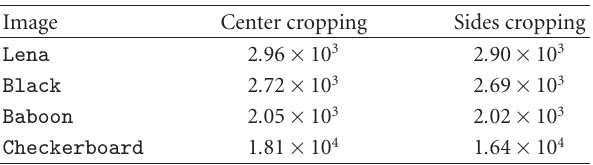
algorithm using original image Lena with di ff erent